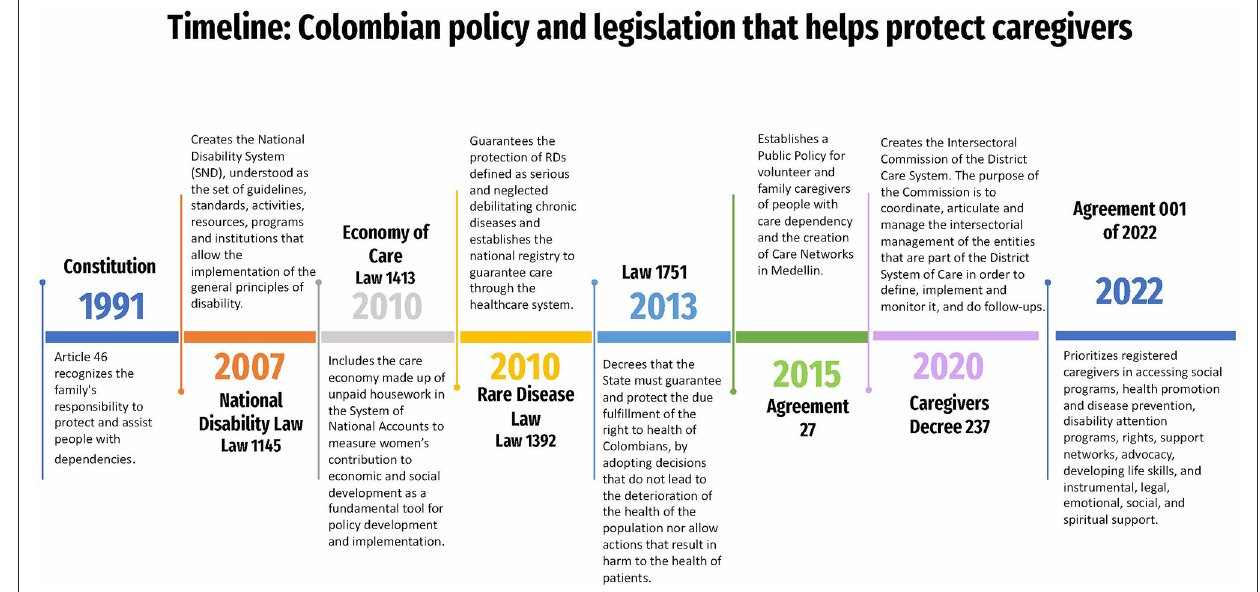
FIGURE3 A timeline of the legislation passed in Colombia that helps protect caregivers. RDs, Rare diseases; LA, Latin America; RD, Rare diseases.